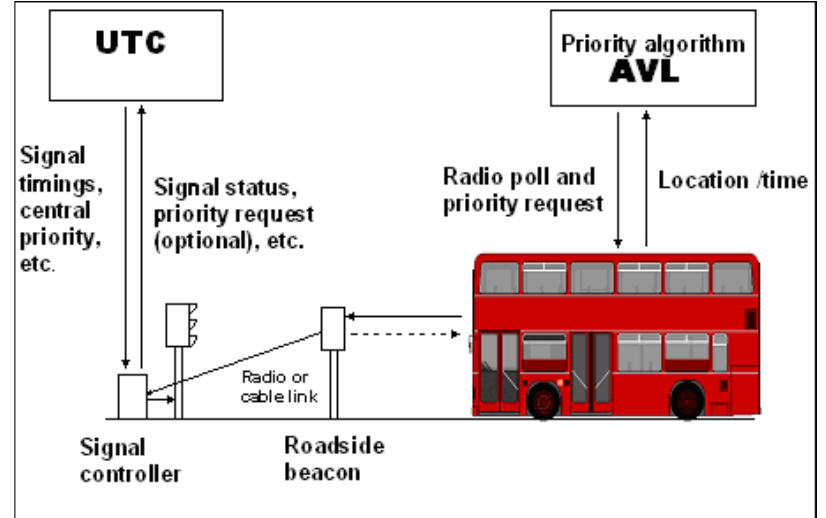
Figure 2. AVL based bus priority architecture in